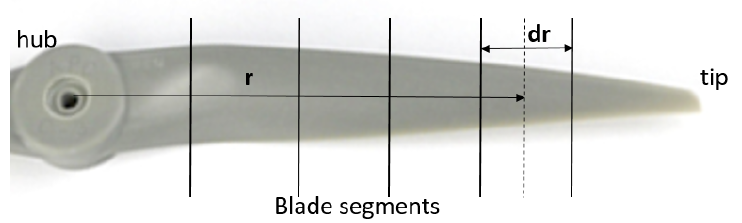
Figure 5. Propeller discretized into blade segments.